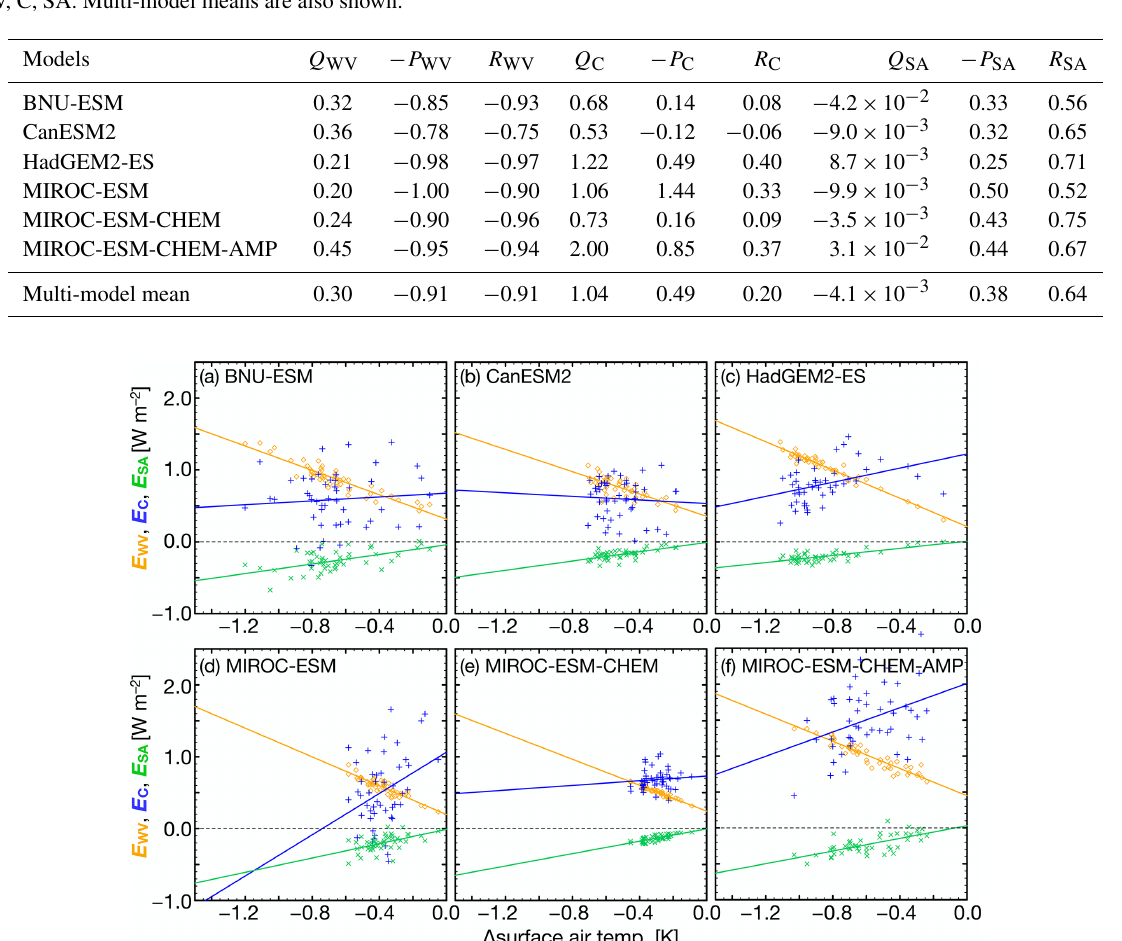
Table 3. Values of rapid adjustment ( Q X ) (Wm − 2 ), feedback parameter ( − P X ) (Wm − 2 K − 1 ), and correlation coefficient ( R X ), where X = WV, C, SA. Multi-model means are also shown.